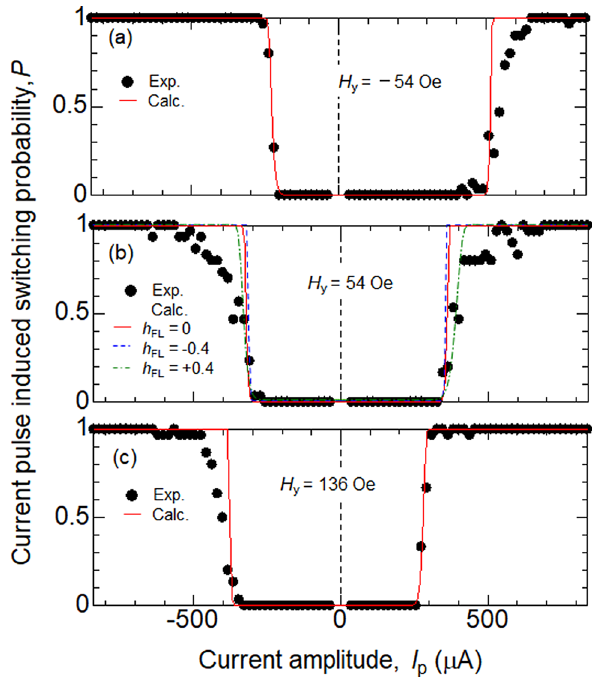
Figure 5. ( a – c ) Magnetization switching probability plotted as a function of the pulse current amplitude I P . The bias field H y is varied as indicated. Switching probability is obtained using 50 ns long pulse current. Symbols represent experimental data, the red solid, blue dashed and green dotted lines show the switching probability calculated using Eq. (1) with different h FL . The parameters used for the fitting are listed in Table